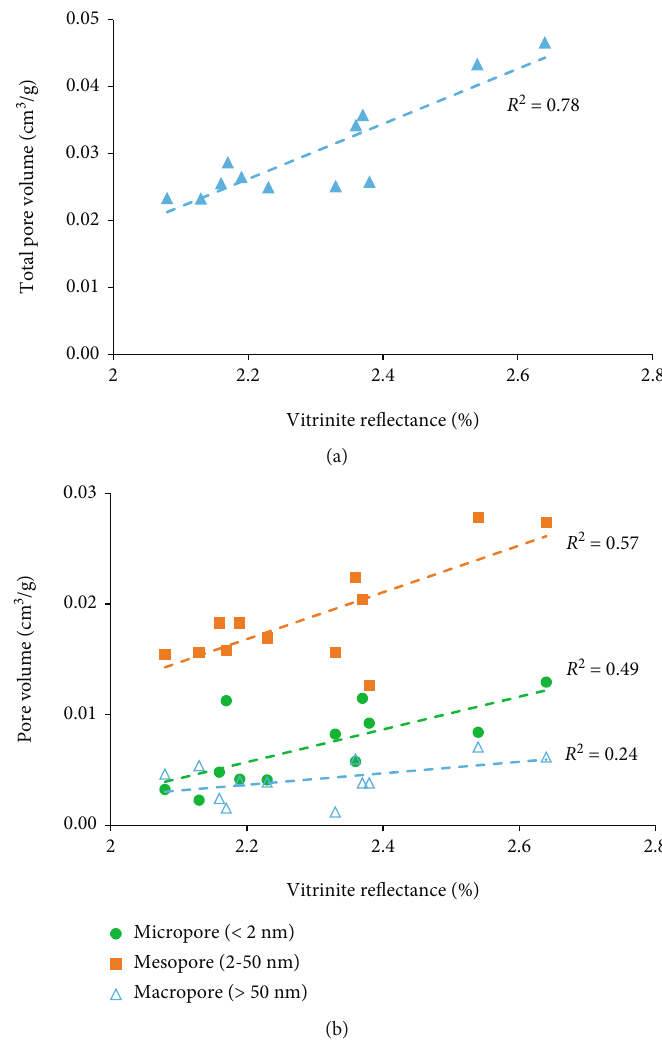
Figure 9: Cross-plots of vitrinite re fl ectance with (a) total PV and (b)